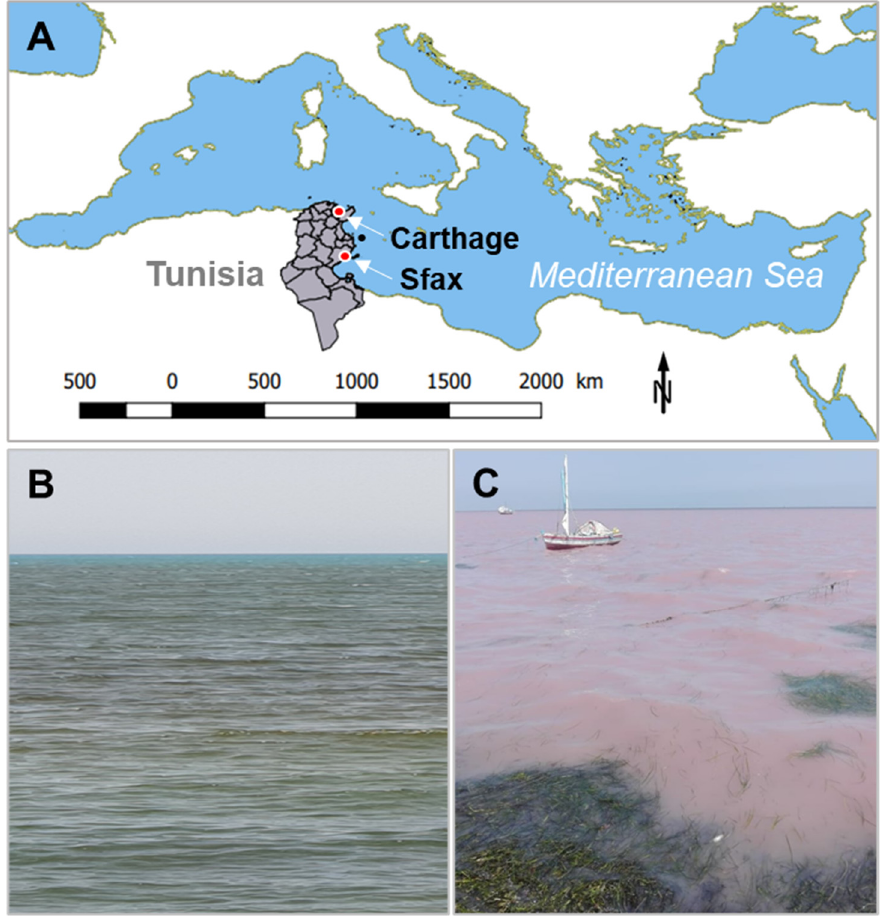
Figure 1. Locations of the sampling sites on the coast of the South Mediterranean Sea. The site of Salammbô is located at Carthage (CAR) in the Gulf of Tunis (northeastern Tunisia), and the site of Sidi Mansour (SM) is located at Sfax on the coast of the Gulf of Gabès (southeastern Tunisia) ( A ). Photographs of brownish ( B ) and red ( C ) seawater discoloration caused by the bloom species G. impudicum and A. minutum at Carthage and Sidi Mansour, respectively.